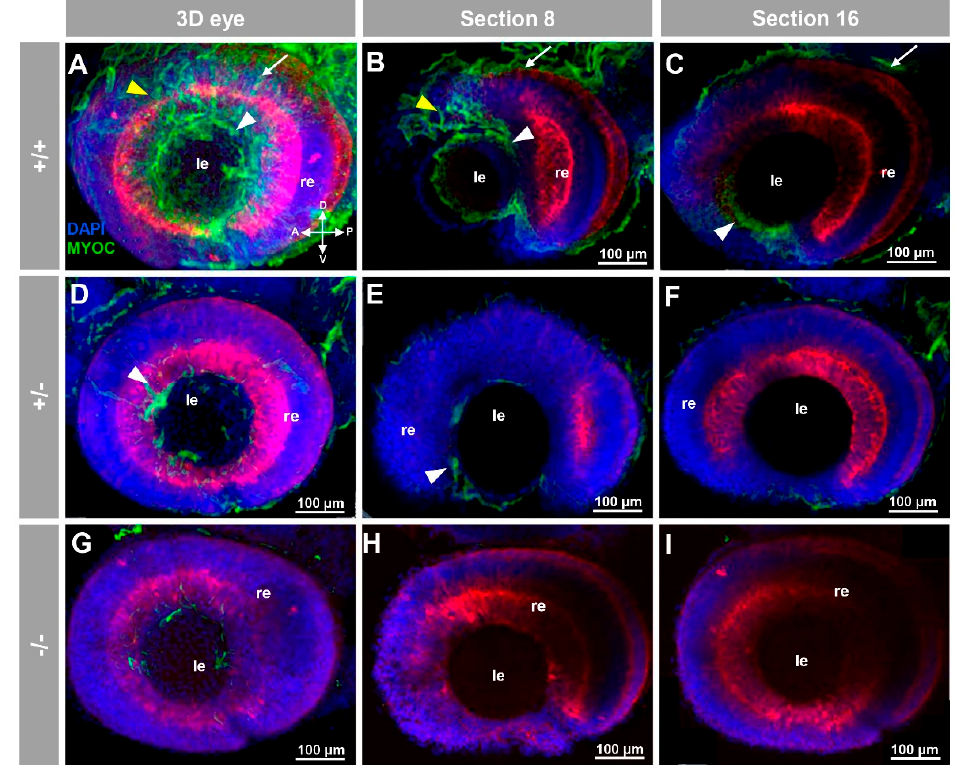
Figure 2. Fluorescent whole-mount immunohistochemical detection of myocilin in the eye of zebrafish embryos (96hpf). Wild-type ( A – C ), heterozygous ( D – F ) and homozygous ( G – I ) myoc mutant embryos were incubated with a chicken conjugated goat anti-chicken IgY secondary antibody. Three-dimensional reconstruction from z-stack scanned confocal microscopy images ( A , D , G ) of the eye. Optical sections (92 µm) 8 ( B , E , H ) and 16 ( C , F , I ), from the exterior ocular surface, were selected from z-stack images to show the precise localisation of the green signal in the external and internal surface of the optic cup (white arrows and yellow arrowheads, respectively), lens epithelium (white arrowhead), and dorsoposterior and ventral periocular tissues (yellow arrowheads) ( A – C ). Blue: DAPI nuclear staining. Green: Cy2-conjugated goat anti-chicken IgY secondary antibody. Red: tissue autofluorescence. The cross indicates the position of the embryonic axes (D: dorsal; P: posterior; V: ventral; A: anterior). The images are representative of the result observed in 10 embryos. le: lens. re: retina. The negative controls are shown in Figures S3A–C. Two-dimensional confocal image z-stacks are shown in supplementary video 1.